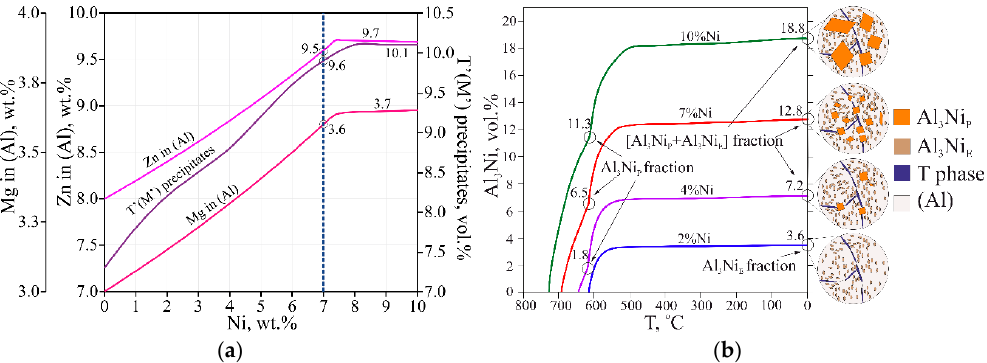
Figure 3. ( a ) Composition of the (Al) solid solution at 470 °C and corresponding volume fraction of T’ (M’) precipitates at 200 °C depending on nickel content in Al-8%Zn-3%Mg; ( b ) relationship between volume fraction of Al 3 Ni phase and temperature at various nickel contents in Al-8%Zn-3%Mg alloy and schematic display of the structure evolution.